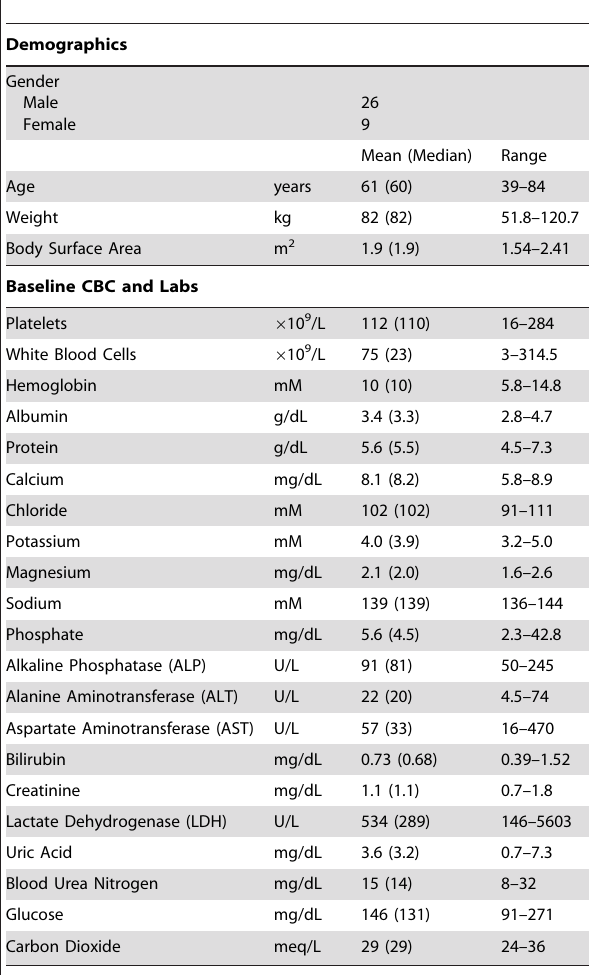
Table 1. Demographics and baseline labs of patients included in pharmacogenetic analyses